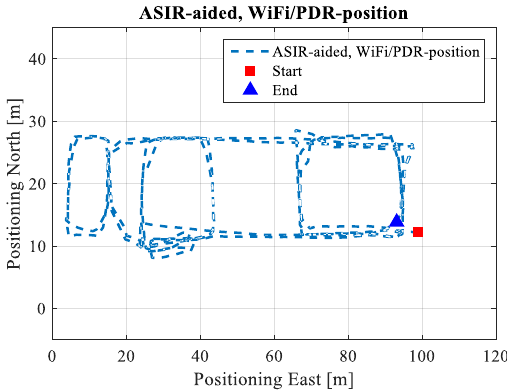
Figure 11. Map/INS/Wi-Fi integrated position using